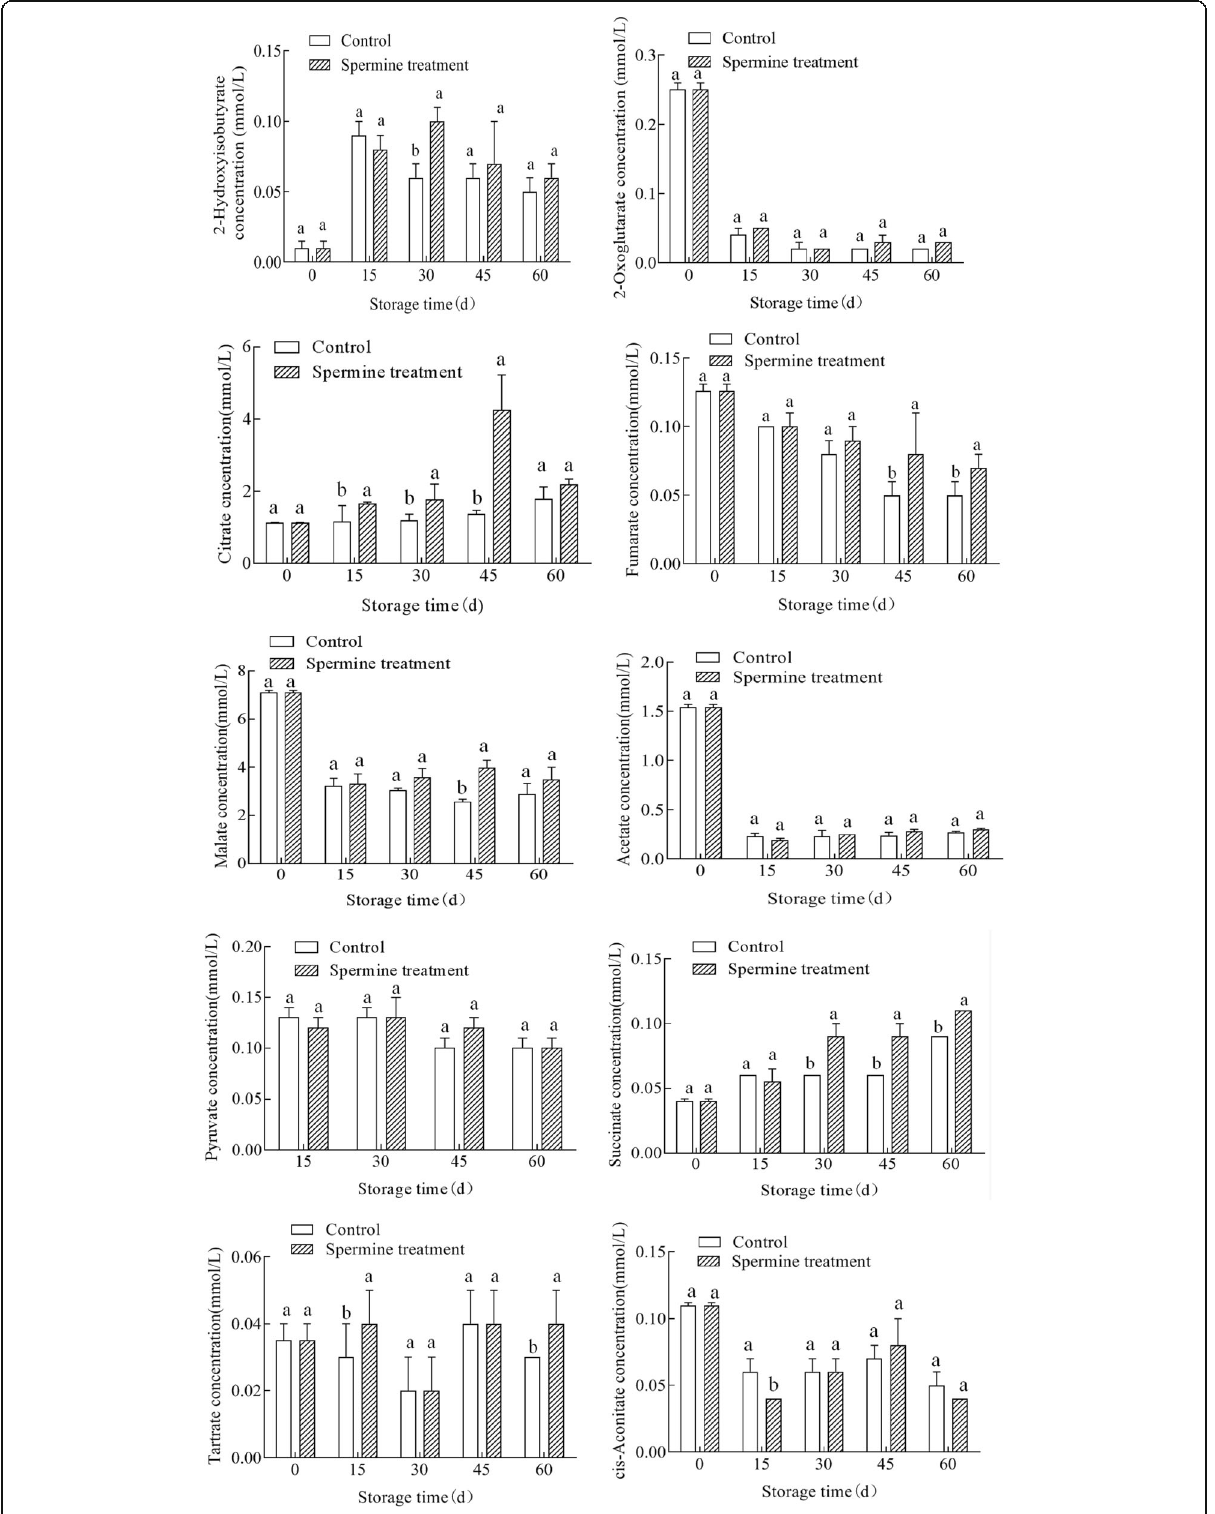
Fig. 5 Effect of exogenous spermine on the concentration of organic acids in cold-stored immature vegetable